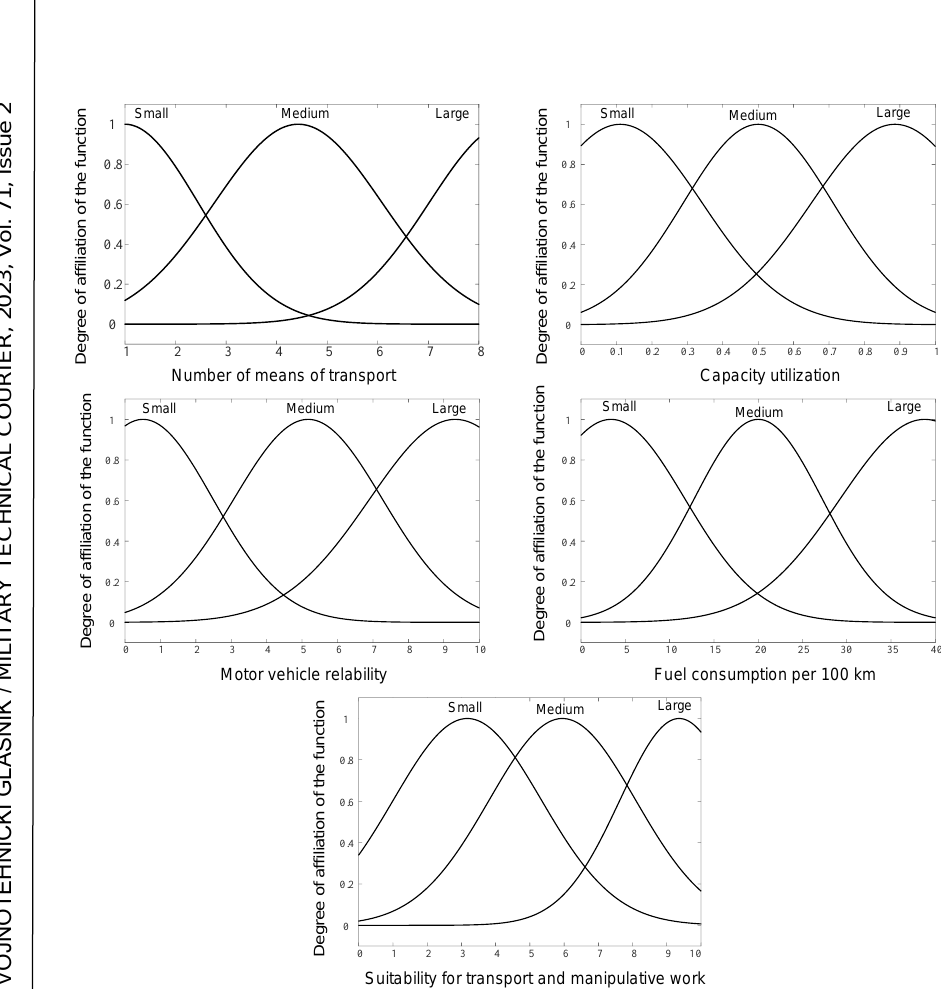
Figure 5 – Membership functions of the input linguistic variables Рис. 5 – Функции принадлежности входных лингвистических переменных Слика 5 – Функције припадности улазних лингвистичких